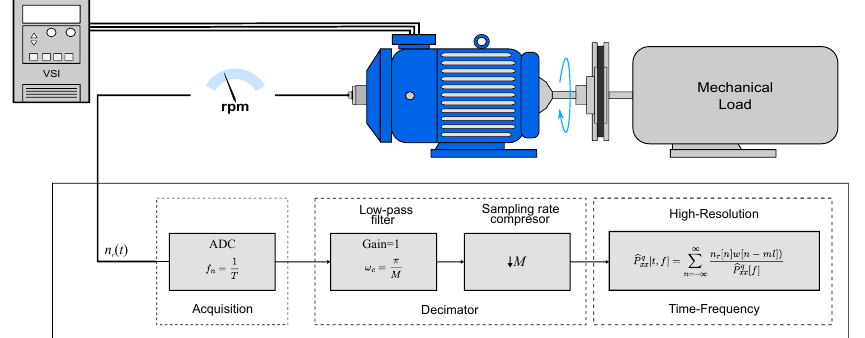
Figure 4. Simplified block diagram of the decimation